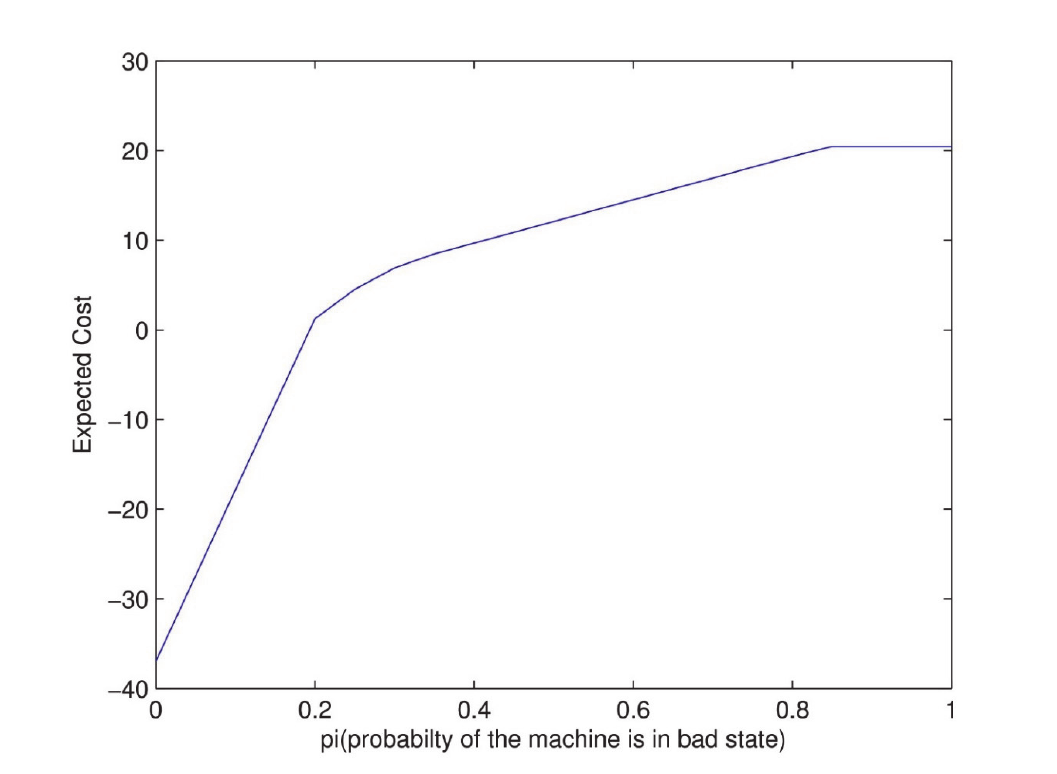
Fig. 5. Diagram of the expected costs for each